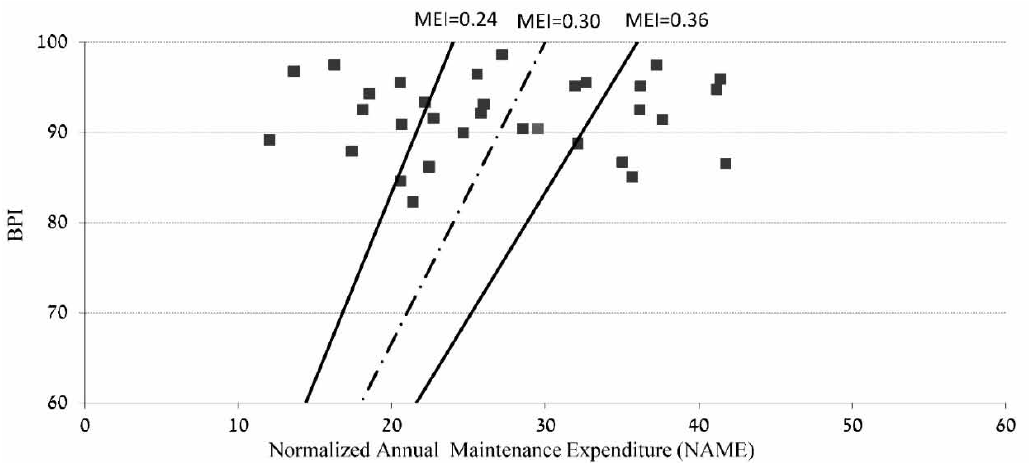
Fig. 4. Building Performance Indicator ( BPI ) against Normalized Annual Maintenance Expenditure ( NAME ) for the sample of